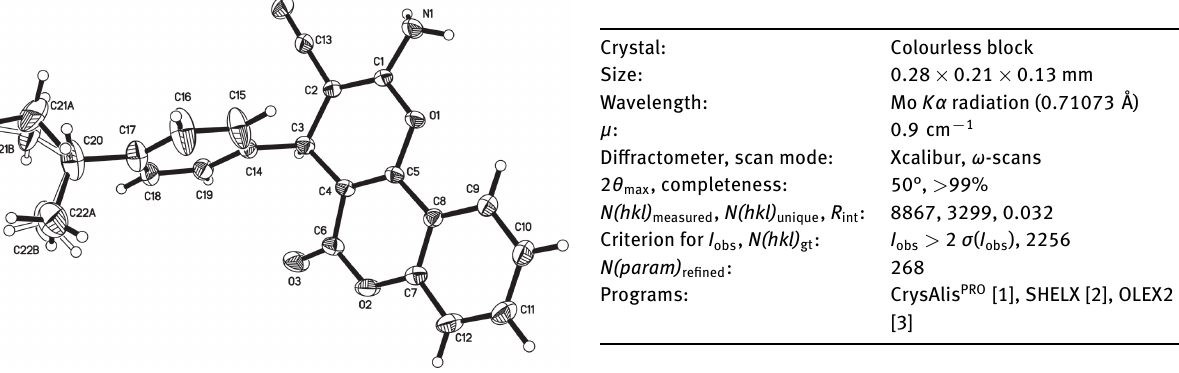
Table 1: Data collection and handling.